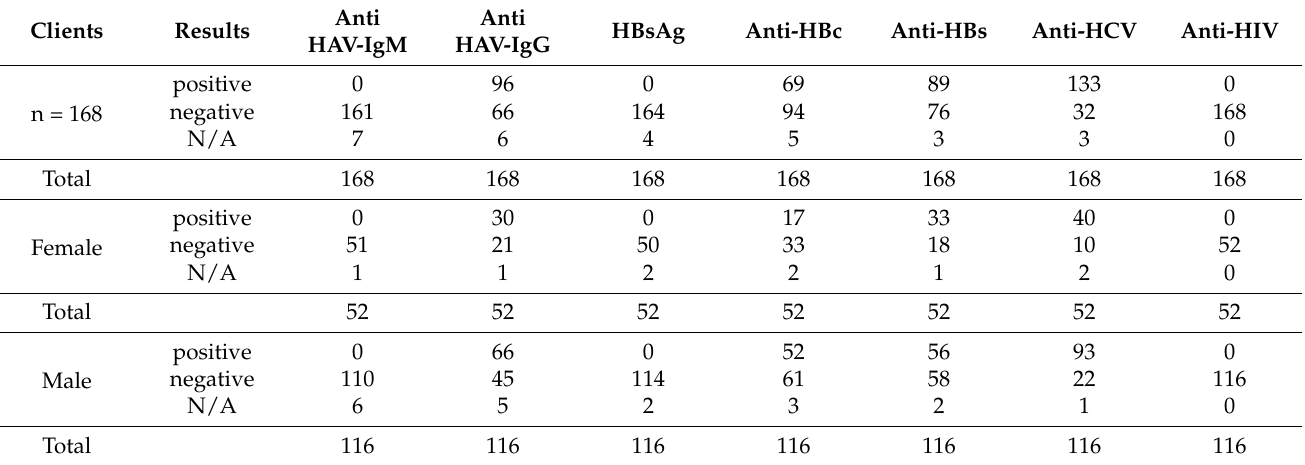
Table 2. Serological results. N/A—not available (patients were not serologically tested due to a small amount of serum